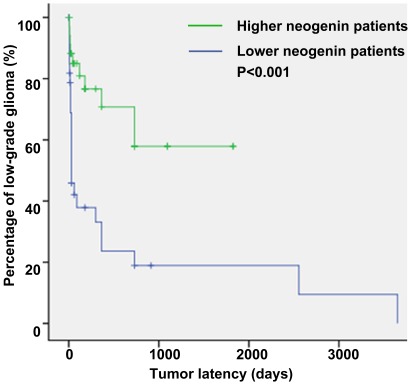
Kaplan-Meier survival curves for overall progression to high-grade glioma.Failure event for computation of this curve was diagnosed as the high-grade glioma. Higher neogenin patients are marked in green color, lower neogenin patients are marked in blue color.